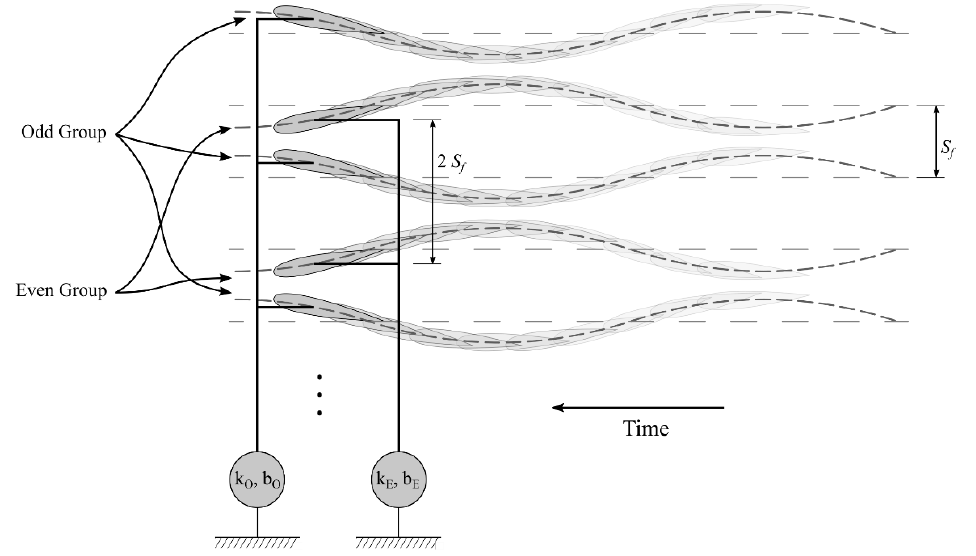
Figure 2. Schematic of the proposed multiple-foil configuration. Each group of foils is attached to a PTO.